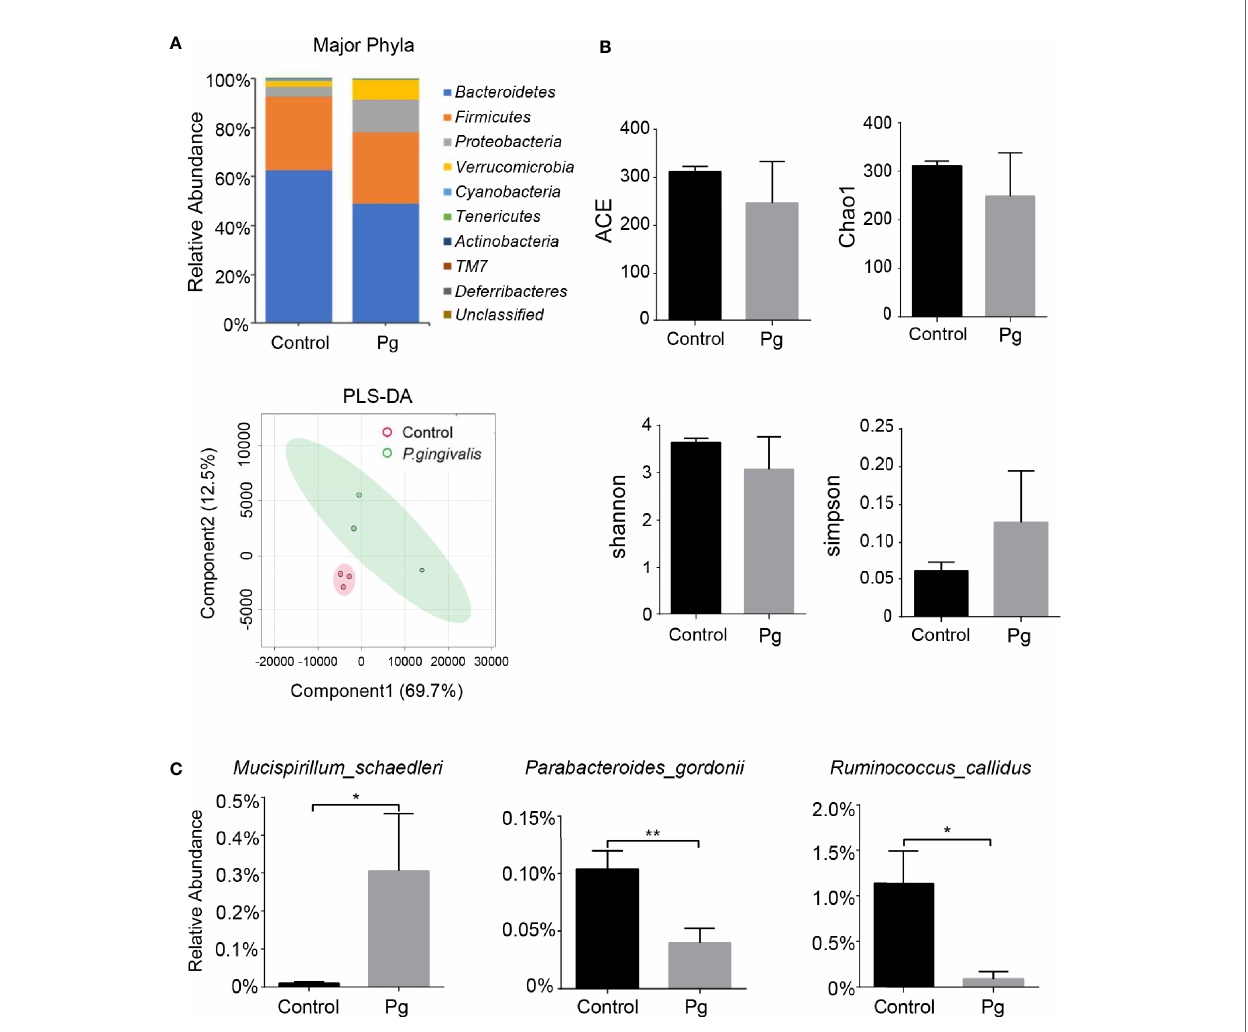
FIGURE 2 | In fl uence of oral gavage with Pg on the composition of gut microbiota. Mice were subjected to oral gavage with either 10 9 CFU of Pg or CMC three times a week for 4 weeks. Stool samples were used for 16S rRNA sequencing. (A) At the phyla level, the relative abundance of bacteria in the Pg-administered and control groups. (B) Alpha- and beta-diversity of the gut microbiota in the Pg-administered and control groups. (C) The signi fi cant differences in relative abundance of species between the two groups. n = 3, data were shown as means ± SEM. * p ≤ 0.05; ** p ≤